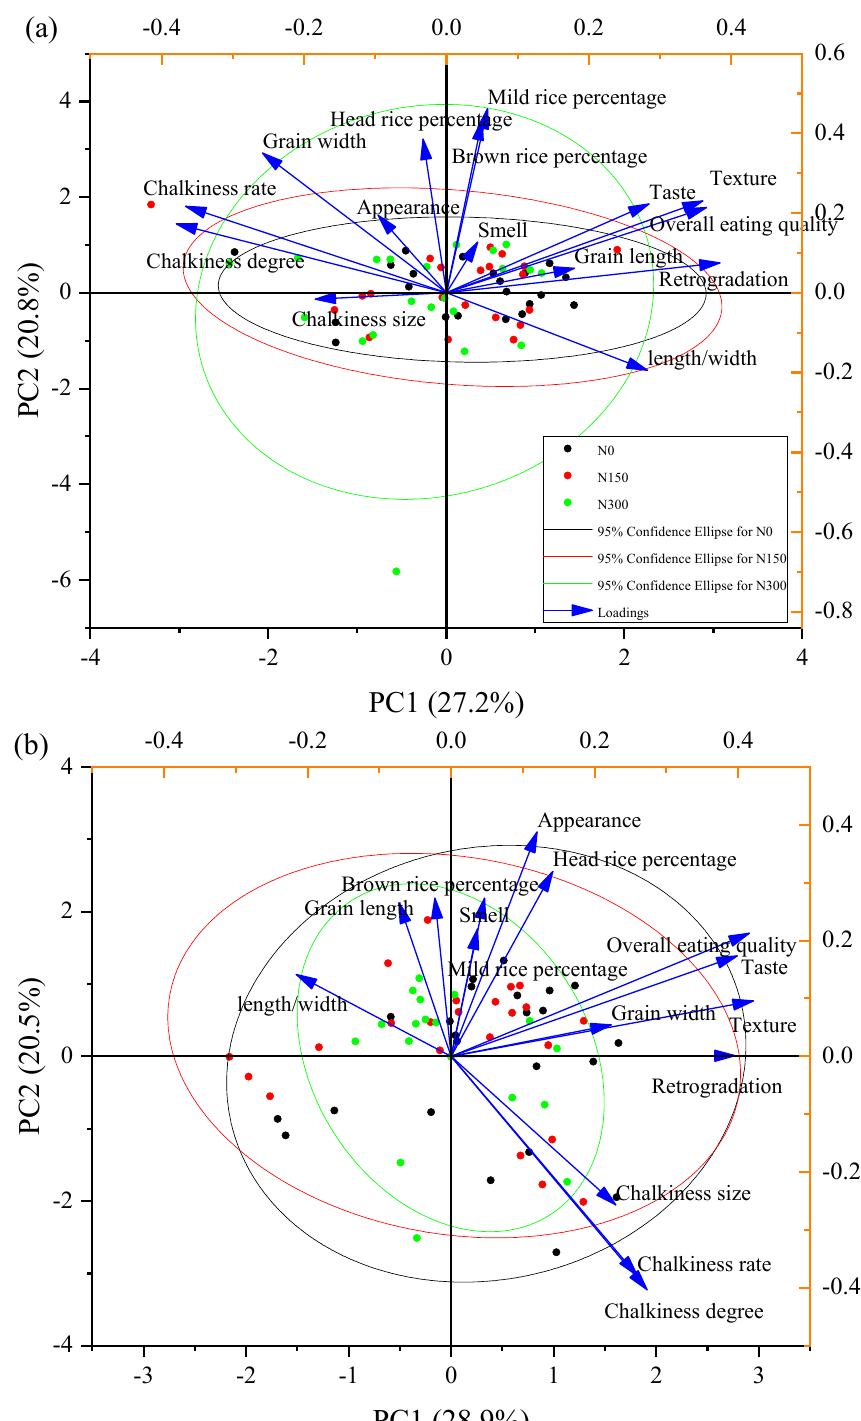
Figure 4. PCA distribution of hybrid indica rice varieties ( a ) and inbred japonica rice varieties ( b ) under three nitrogen levels. N0, N150, and N300 refer to treatments with 0 kg ha − 1 , 150 kg ha − 1 , and 300 kg ha − 1 applied.